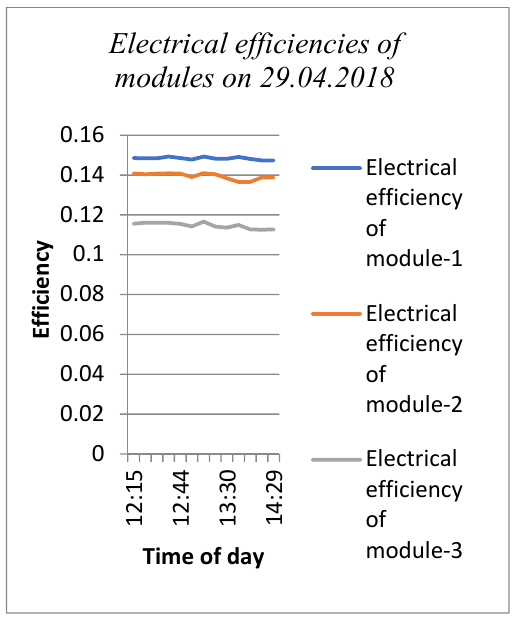
Figure 10. Electrical efficiencies of modules on 29.04.2018.